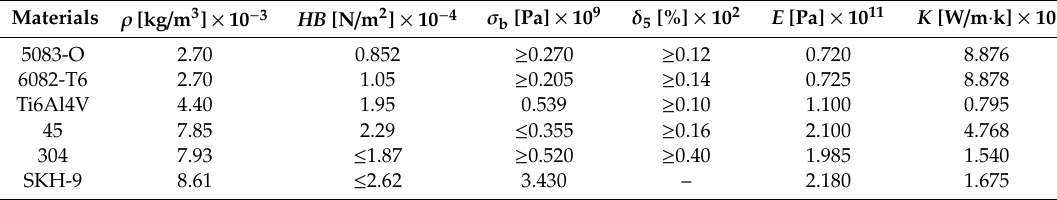
Table 1. Mechanical properties of the workpiece [33].